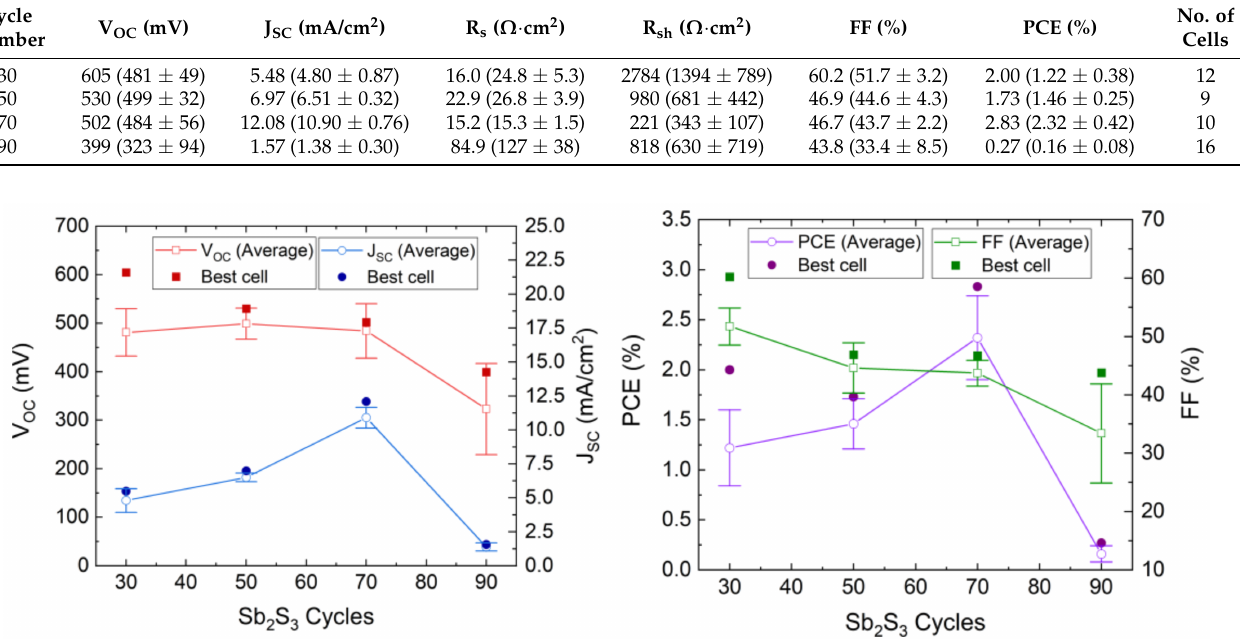
Figure 9. Evolution of the V OC , J SC , FF, and PCE values of the ETA solar cells made of ZnO/TiO 2 core–shell NW heterostructures covered with a Sb 2 S 3 shell grown by CSP as a function of the cycle number. Horizontal bars denote standard